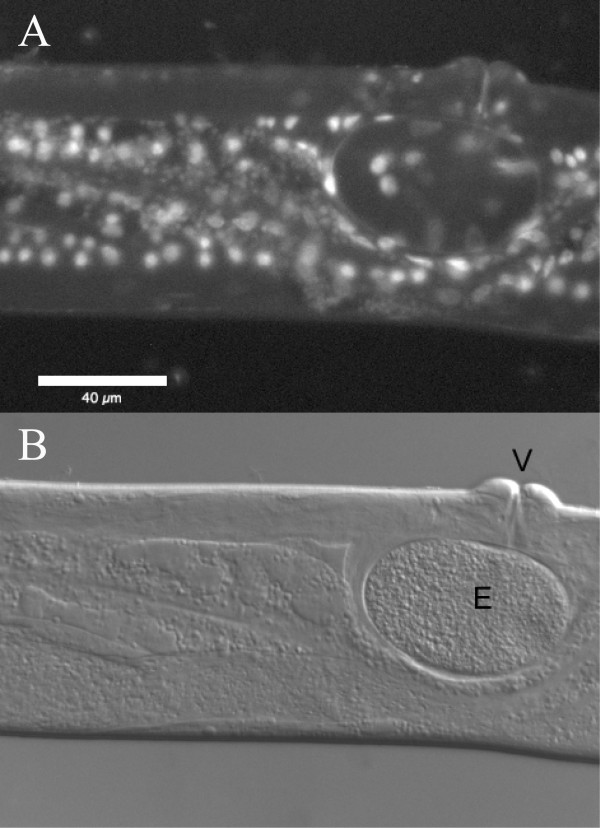
Lack of sperm and sperm nuclei from parthenogenetic Panagrolaimus strain JB115. DIC imaging was used to search for sperm and epifluorescence to search for compact sperm nuclei (none were observed). See Methods for details. An egg is indicated by "E" and the vulva is indicated by "V". The scalebar represents 40 μm.